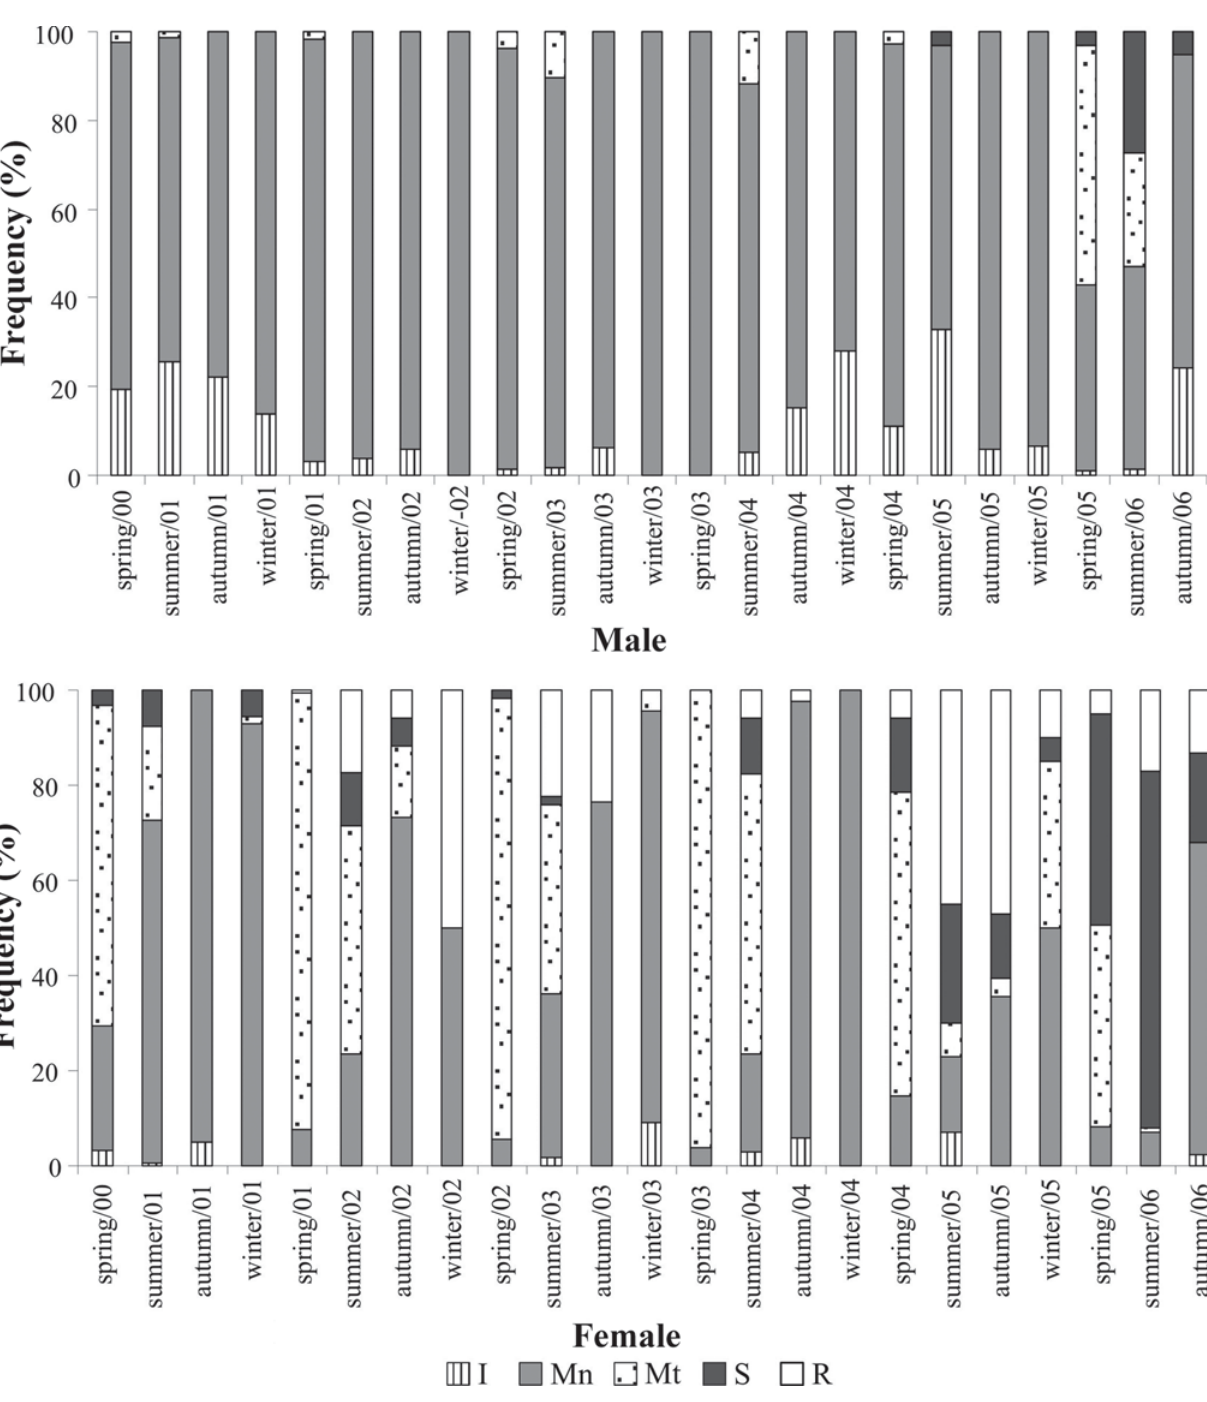
Fig. 7. Seasonal abundance (%) of the gonadal maturation stages for males and females of Acestrorhynchus pantaneiro in the upper Uruguay